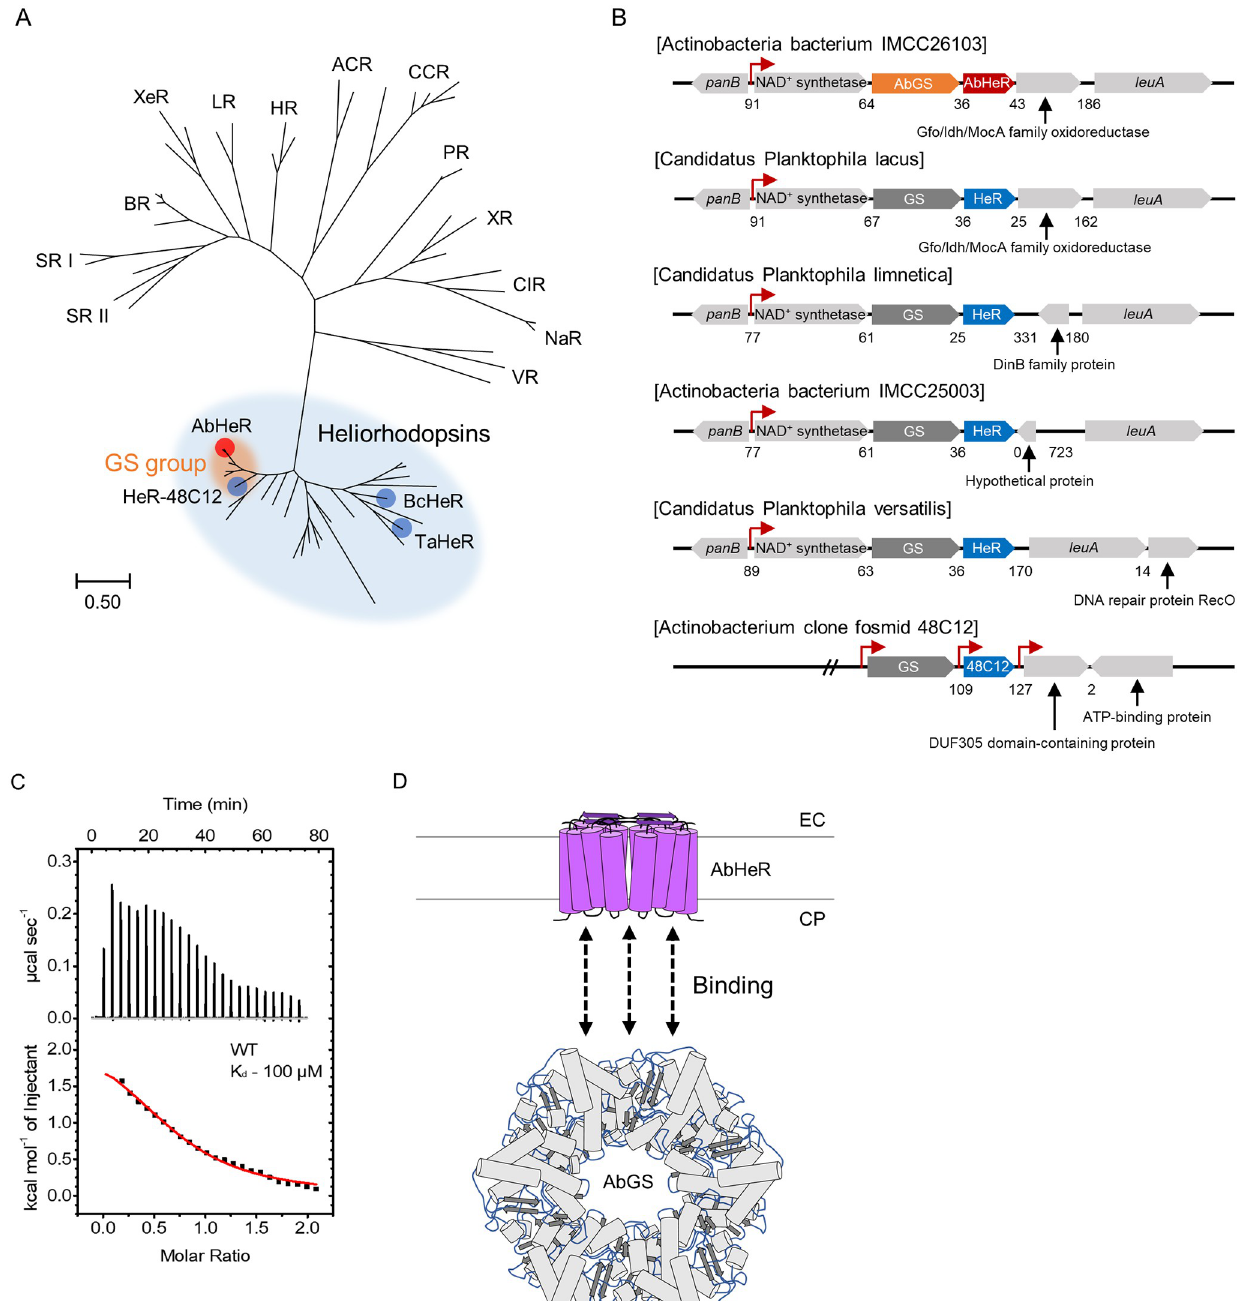
Fig 1. Identification of AbGS binding to AbHeR. (A) Relationship between microbial rhodopsin and heliorhodopsin. The unrooted maximum likelihood tree is shown. Blue oval, blue circle, red circle, and orange oval represent heliorhodopsins clade, reported heliorhodopsins, AbHeR, and heliorhodopsins containing GS gene, respectively. (B) Each eubacterium contains GS and heliorhodopsin arranged in operons in the indicated direction. Nucleotide gaps between HeR and GS are indicated. AbGS and AbHeR are indicated by orange and red arrows, respectively. Predicted GS and other heliorhodopsin are indicated by gray and blue arrows, respectively. Promoters in each operon are expressed by red bent arrows and predicted using phiSITE, Softberry, BDGP, and SAPPHIRE. (C) PPI between AbHeR and AbGS is determined by isothermal titration calorimetry analysis. The upper and lower panels represent raw data and enthalpy change per mol, respectively. AbGS was continuously added to AbHeR wild type. Nonlinear curves in the lower panels evaluated the best-fit curve. (D) Predicted model of PPI between AbHeR and AbGS. AbHeR dimers are embedded in the membrane, and the N- and C-termini of AbHeR are located in the CP side and EC side, respectively. AbGS dodecamer binds to AbHeR dimers and the potential of interactions between them is indicated by dotted black arrows. The underlying data of the graph can be found in S1 Data. ACR, anion channelrhodopsin; BR, bacteriorhodopsin; CCR,